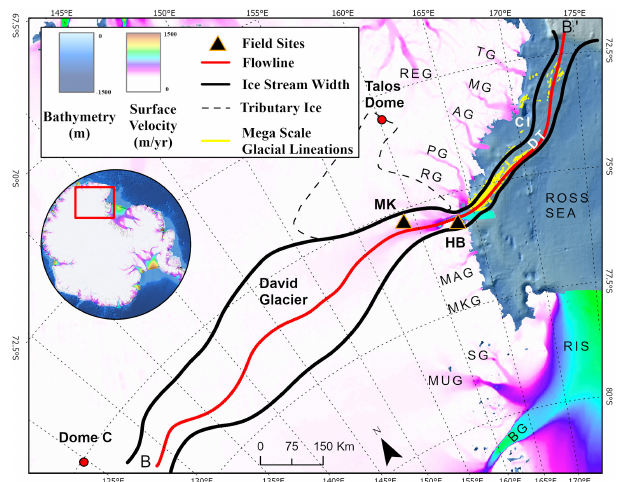
Figure 2. Map of model domain with modern ice surface velocity of Rignot et al. (2011) and bathymetry of Arndt et al. (2013). Flowline follows red line; ice stream width in black. RIS: Ross Ice Shelf; BG: Byrd Glacier; MUG: Mulock Glacier; SG: Skelton Glacier; MKG: Mackay Glacier; MAG: Mawson Glacier; RG: Reeves Glacier; PG: